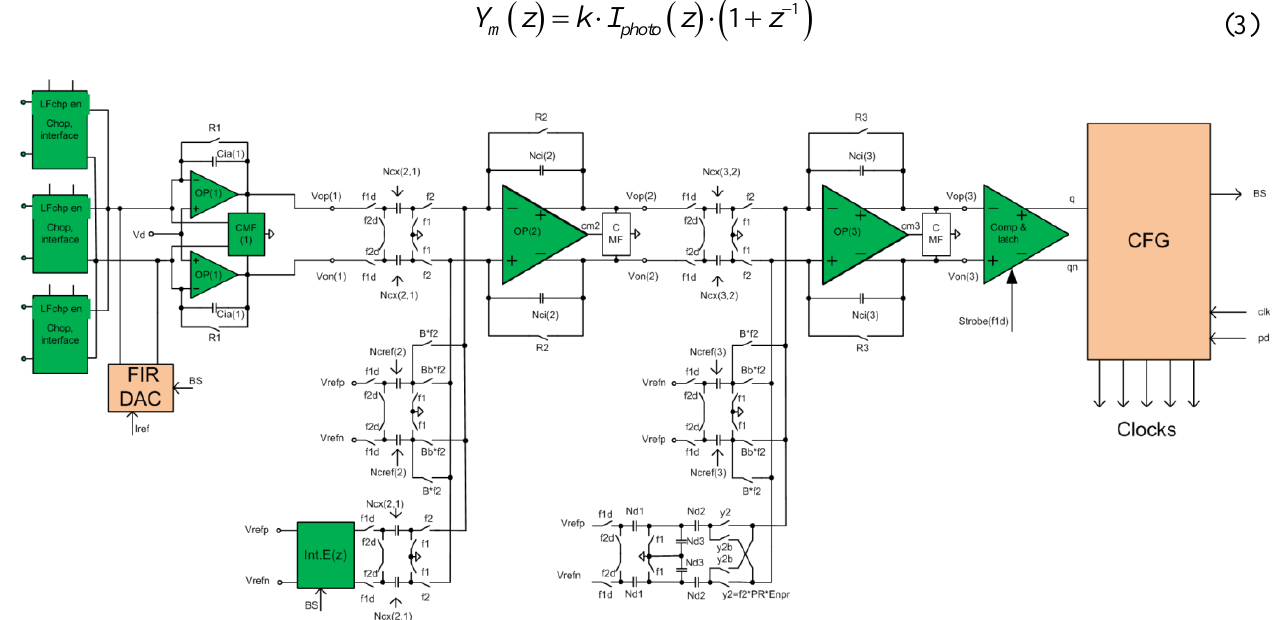
Figure 7. A simplified circuit diagram of a hybrid, 3rd order  modulator with multi-bit FIR-DAC and a corresponding compensation circuit IntEz. It also includes a